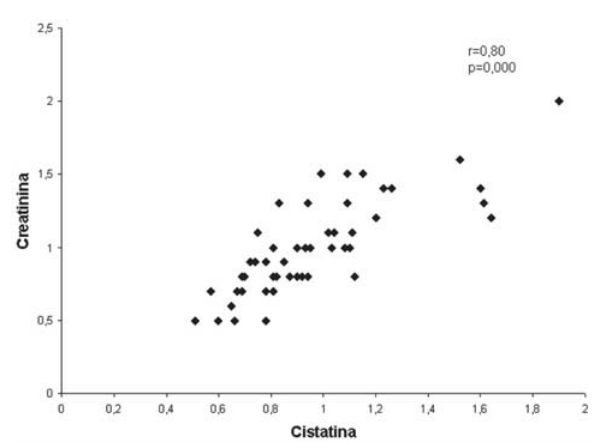
Fig. 3 - Correlação da cistatina C e creatinina no quinto pós- operatório; r: coeficiente de correlação; p: nível de